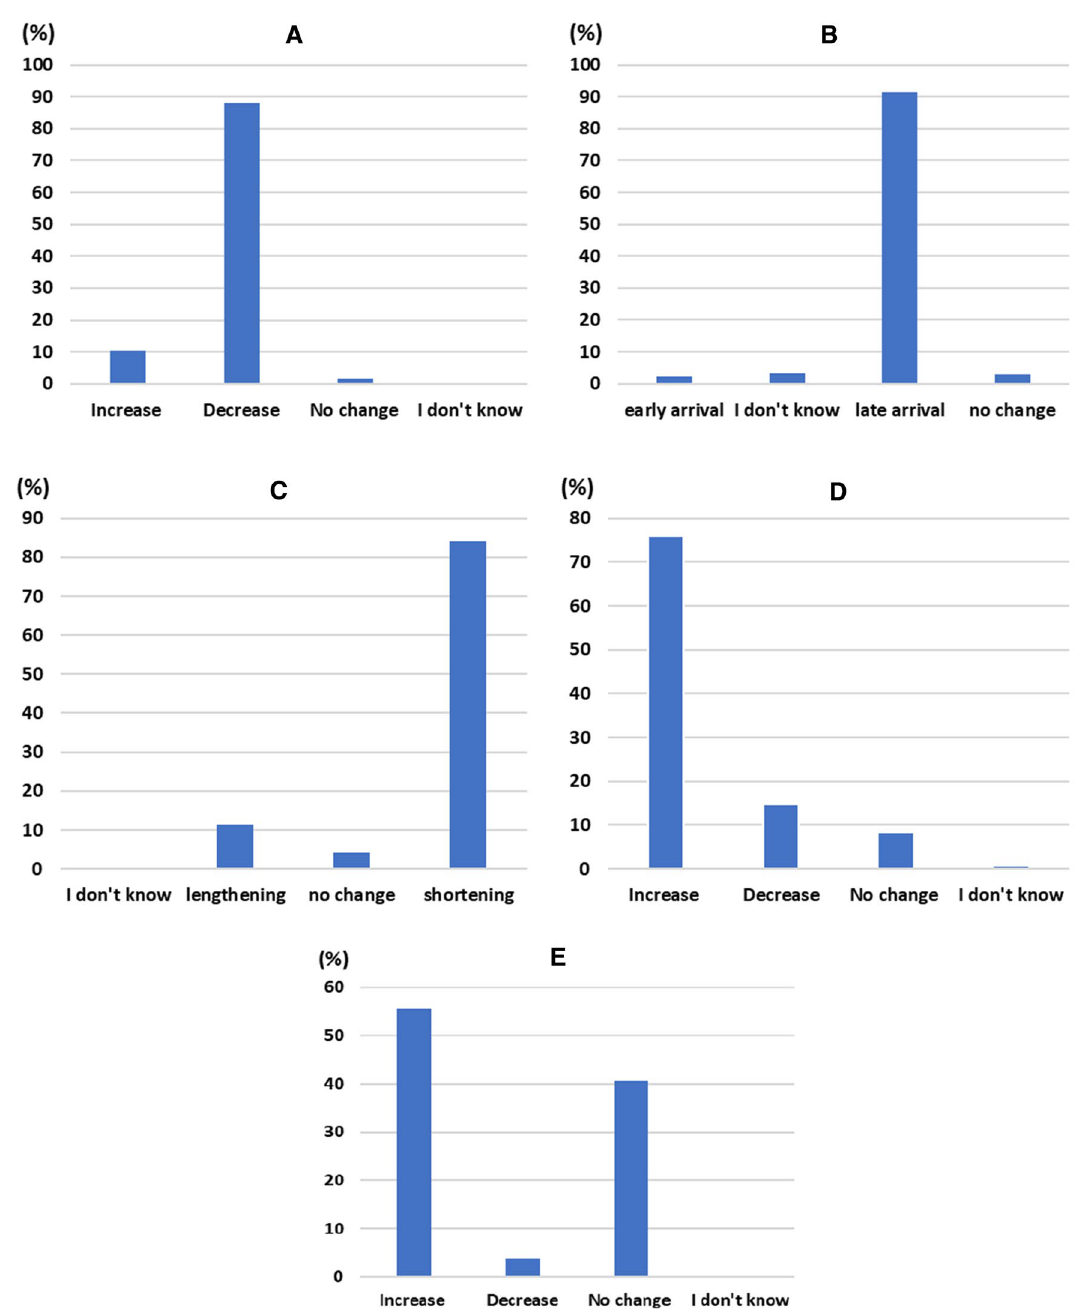
Fig. 3 381 Fishermen’s responses concerning their perception of A change in rainfall, B change in rainy season timing and C length, D change of temperature, and E change in flooding occurrence in Côte d’Ivoire. y axis is the respondent percentage, x axis represents the cat- egories of responses in the considered change climate